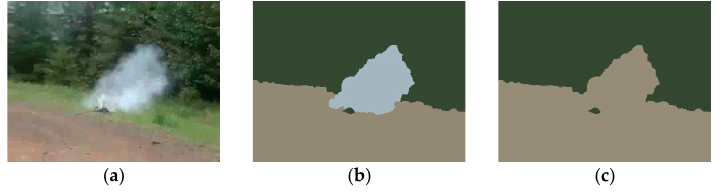
Figure 8. TSDPC output image. ( a ) original smoke image; ( b ) TSDPC result map (the number of clustering centers is 3); ( c ) manually determine 2 clustering centers area.